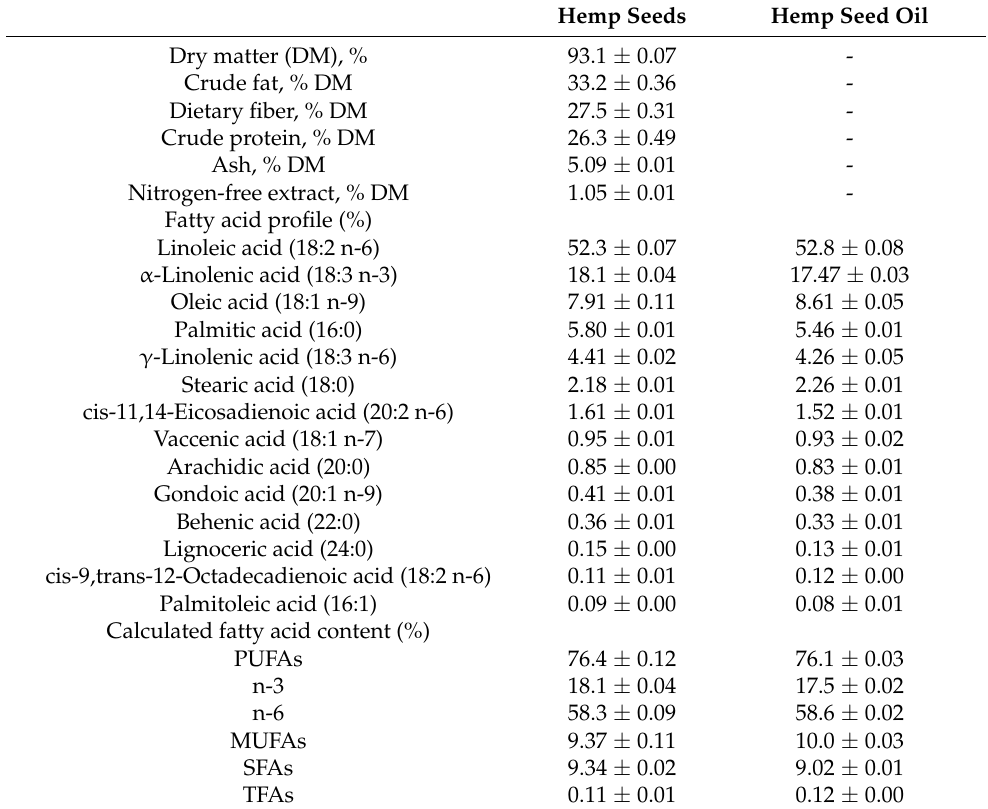
Table 1. The composition of hemp seeds and hemp seed oil 1 .